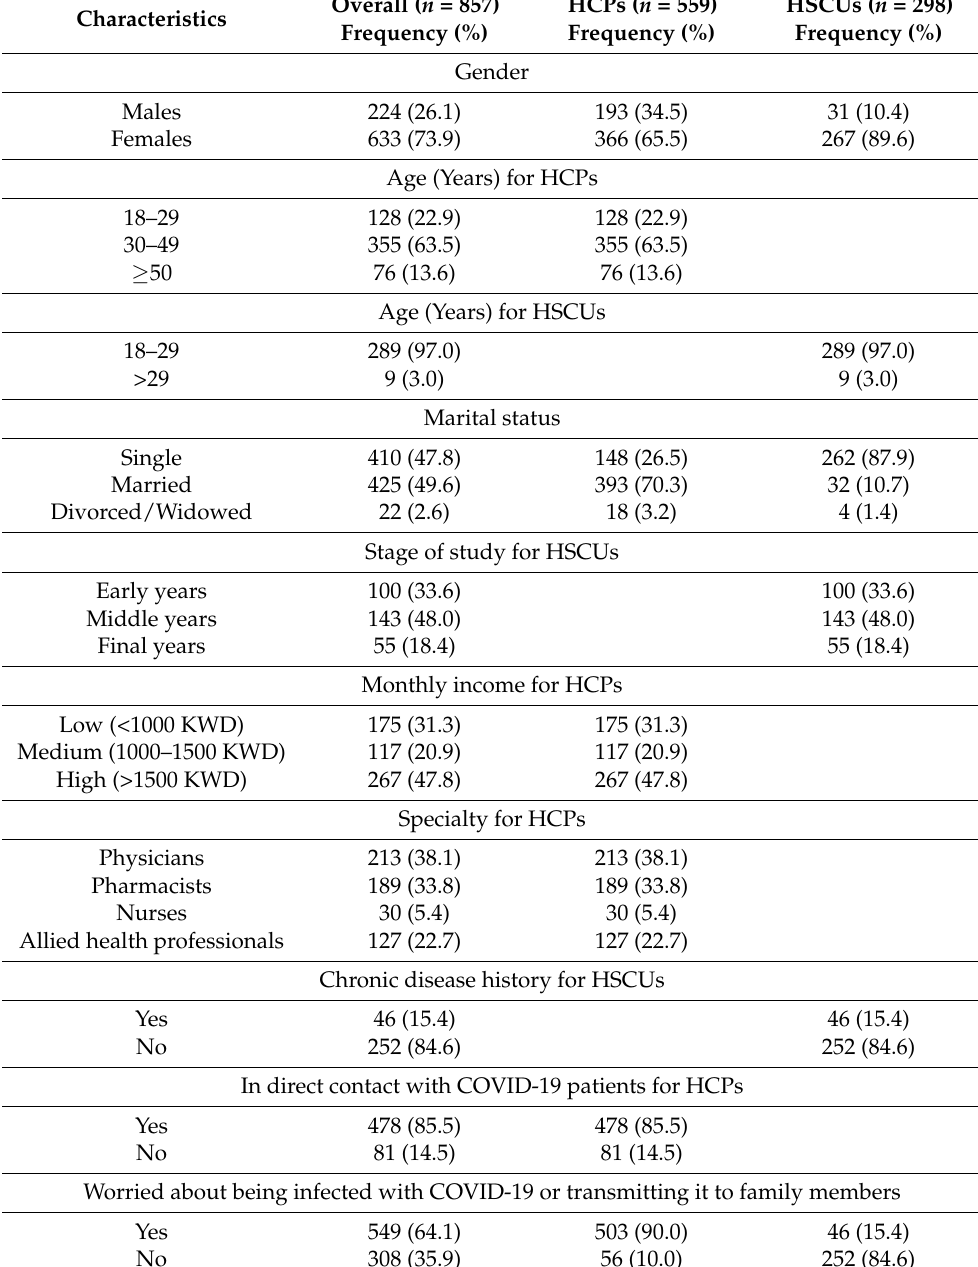
Table 1. Characteristics of the study